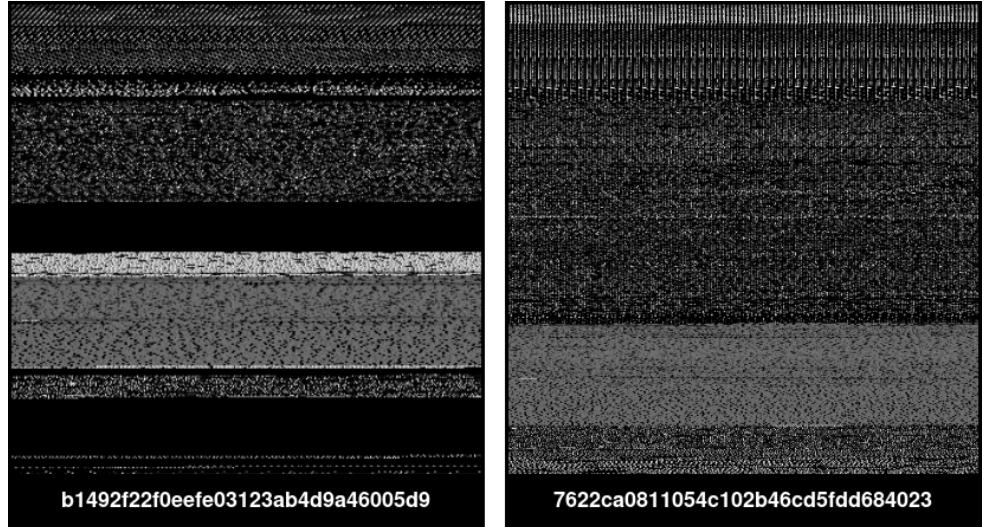
Figure 1. Two examples of Android malware converted into grayscale images: in detail on the left, a sample belonging to the Mecor family, while on the right, a sample obtained from the Airpush